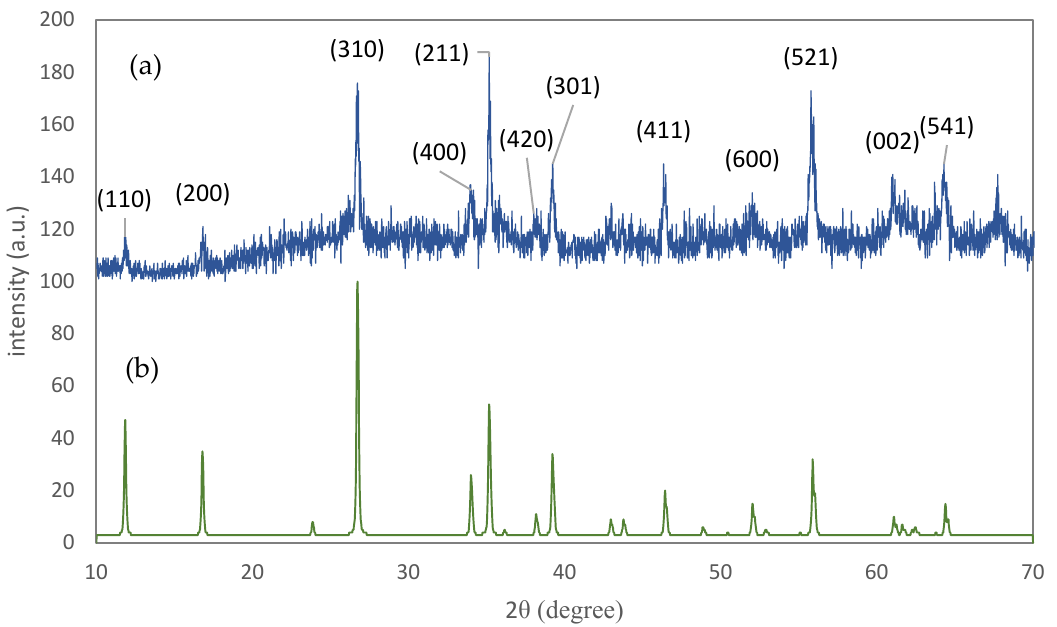
Figure 4. ( a ) The XRD pattern of the powder sample of FeOOH; ( b ) the simulated reference pattern of akaganéite phase according to the JCPDS card number 34 ‐ 1266.